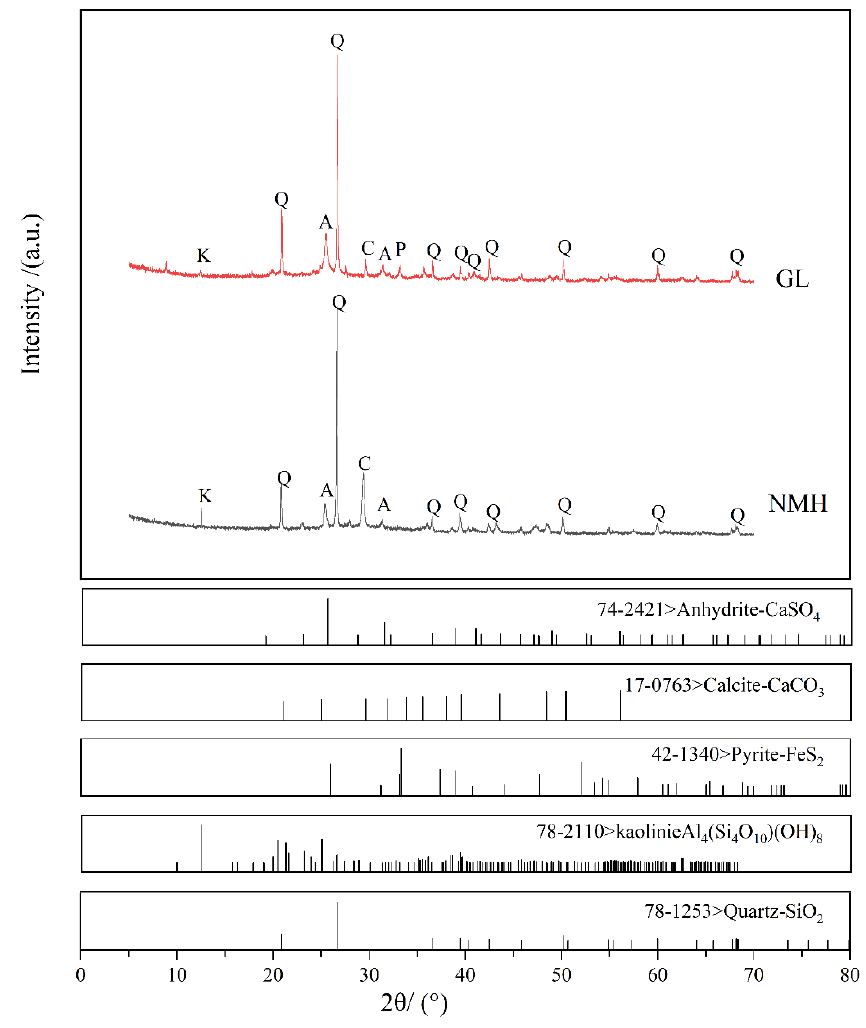
Figure 1. XRD patterns of low-temperature ash of NMH and GL. Q: quartz; A: anhydrite; K: kaolin- ite; P: pyrite; C: calcite. P: pyrite; C: